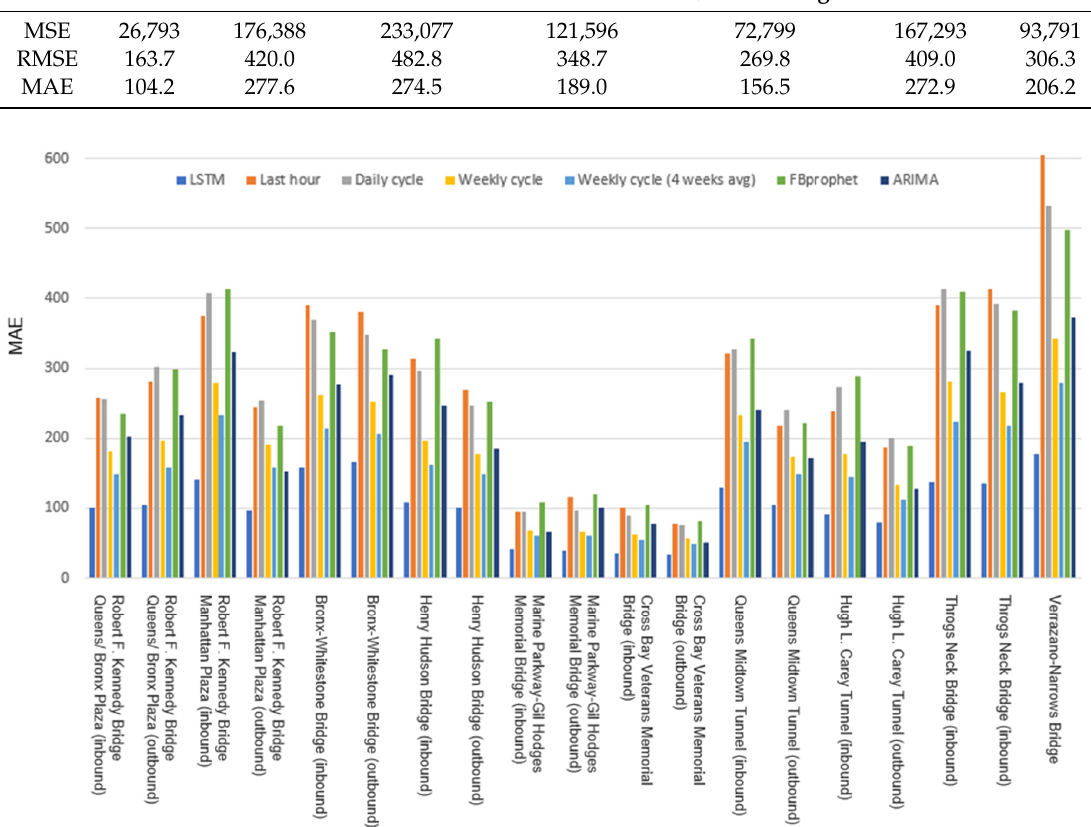
Figure 7. MAE distribution over the 19 reference traffic flows.